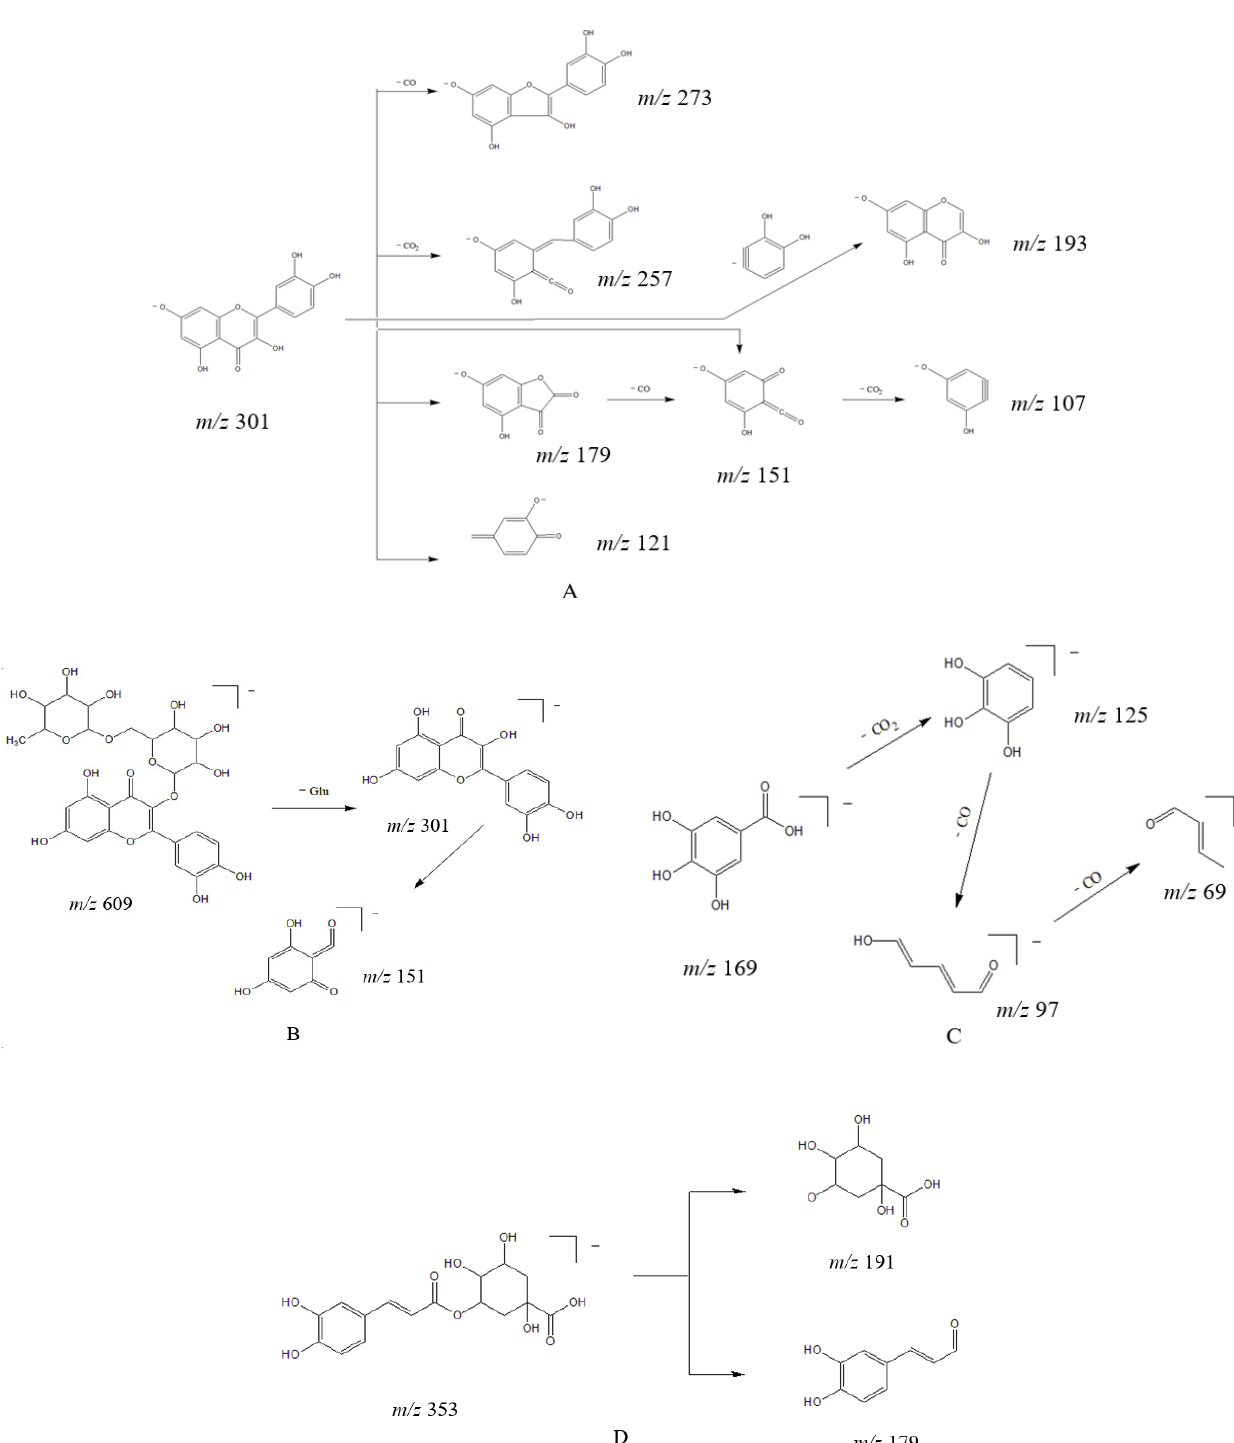
Figure 4. The speculated fragmentation pathways of ( A ) quercetin, ( B ) rutin, ( C ) gallic acid, and ( D ) chlorogenic acid in Lysimachiae Herba.